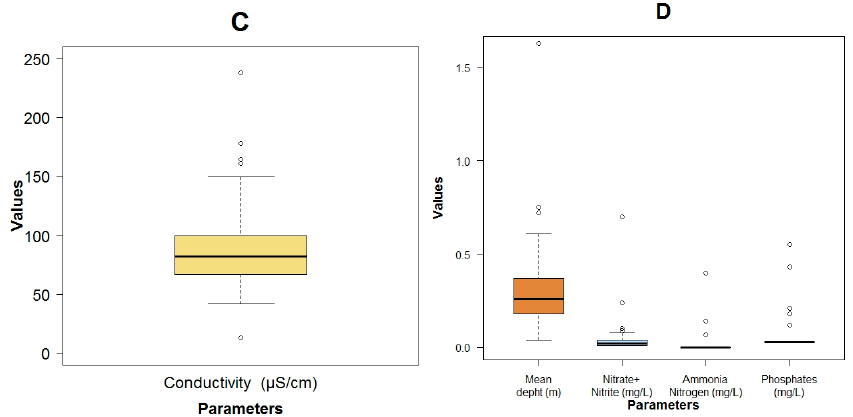
Figure A4. Boxplots of the physicochemical parameters: ( A ) Total Solids; ( B ) Turbidity; ( C ) Conductivity; ( D ) Mean depth, Nitrate + Nitrite, Ammonia Nitrogen and Phosphates.